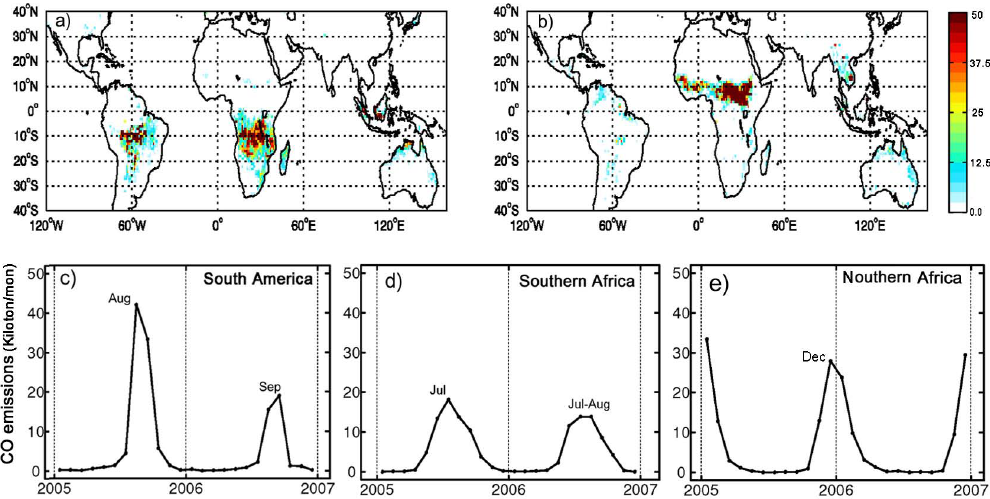
Fig. 1. Mean GFED v2 CO emissions (kilotonmonth − 1 ) averaged for (a) July–October of 2005–2006; (b) November 2005 to February 2006. Time evolution of regional CO emissions (kilotonmonth − 1 ) averaged over (c) South America; (d) southern Africa and (e) northern Africa.